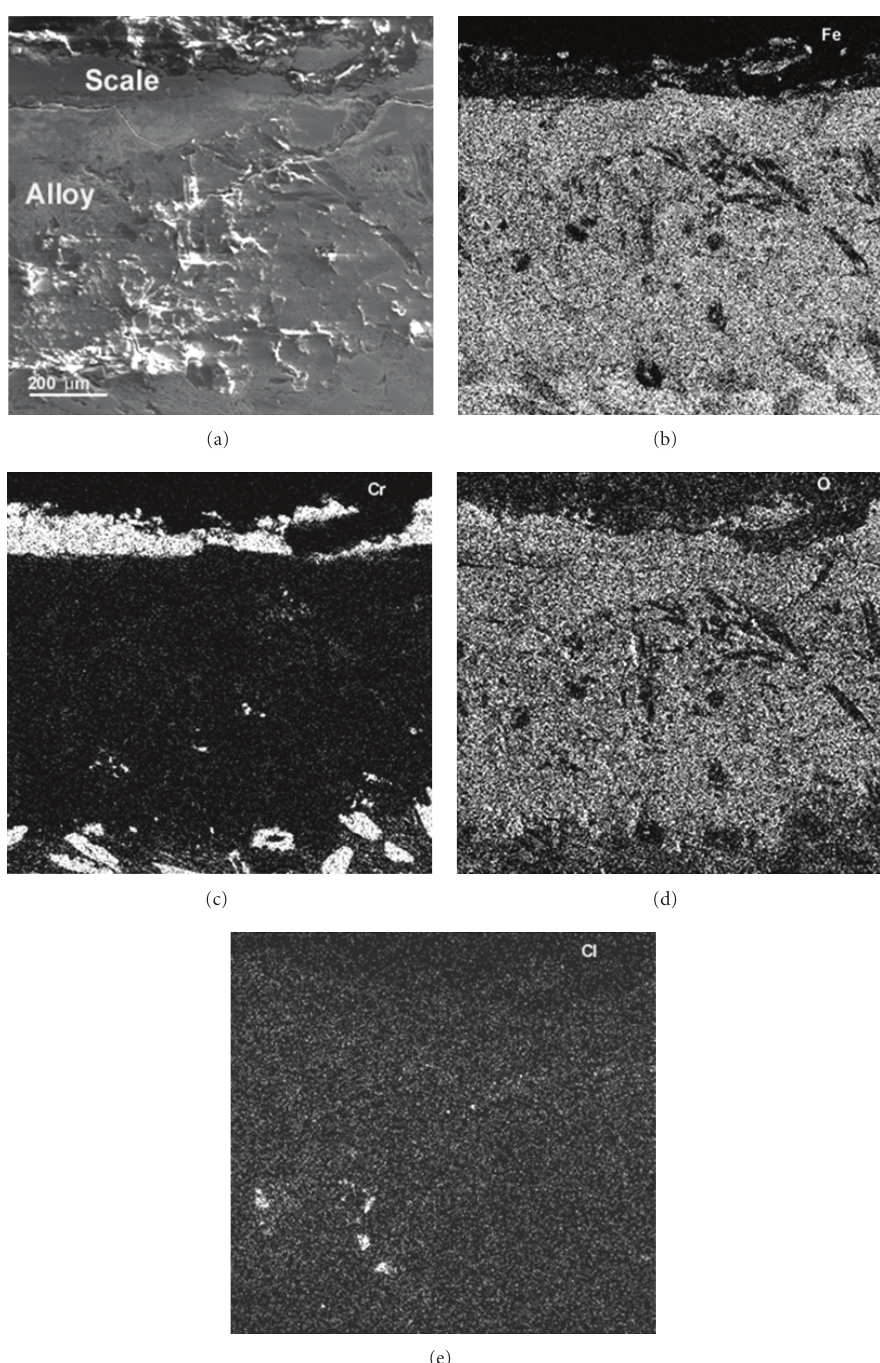
Figure 8: Micrograph of cast iron containing 5.21 C E -corroded NaCl-KCl at 670 ◦ C during 96 h together with X-ray mappings of Fe, Cr, O, and